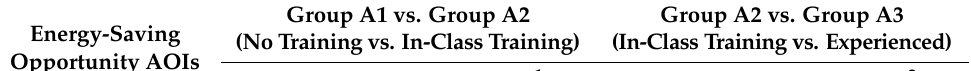
Table 7. Student’s t -test results for comparing the performance of participants in recognizing energy- saving